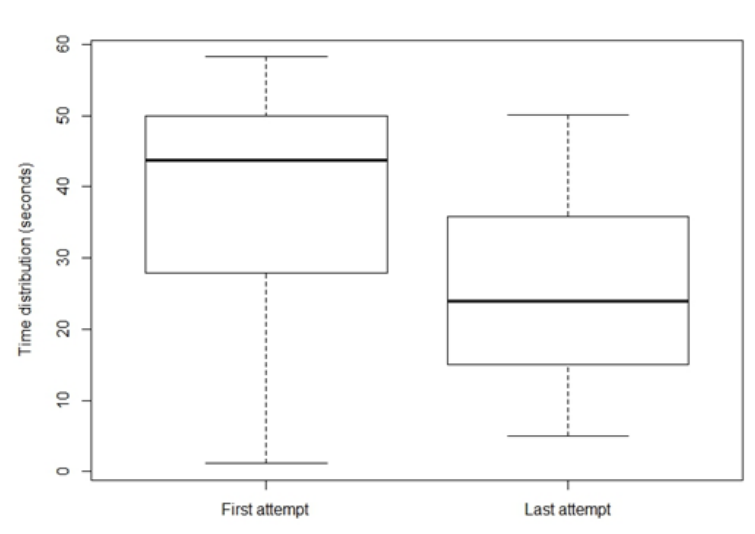
Figure 3. First attempt vs. last attempt on the last online quiz – Student response time